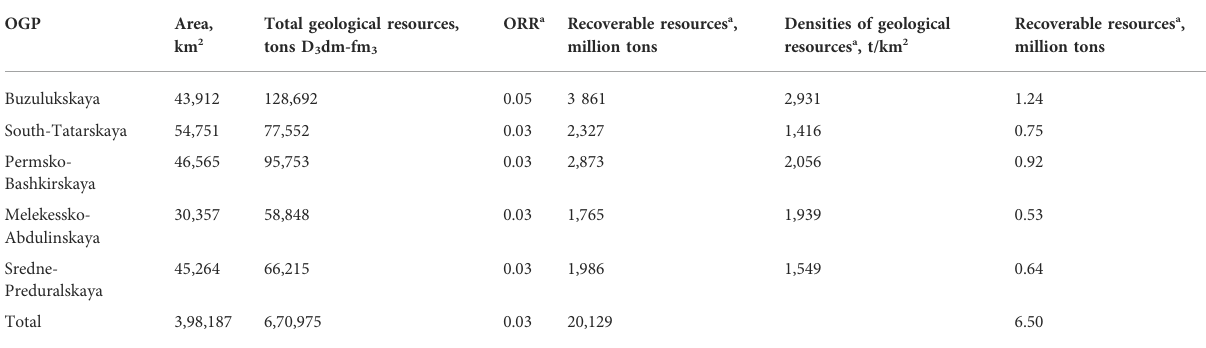
TABLE 9 Resource estimate for unconventional accumulations of hydrocarbon in the high-carbon Domanik strata of Volga-Ural OGP (Prischepa et al., 2014; Varlamov et al., 2017; Fortunatova et al., 2019a; Fortunatova et al., 2021). OGP